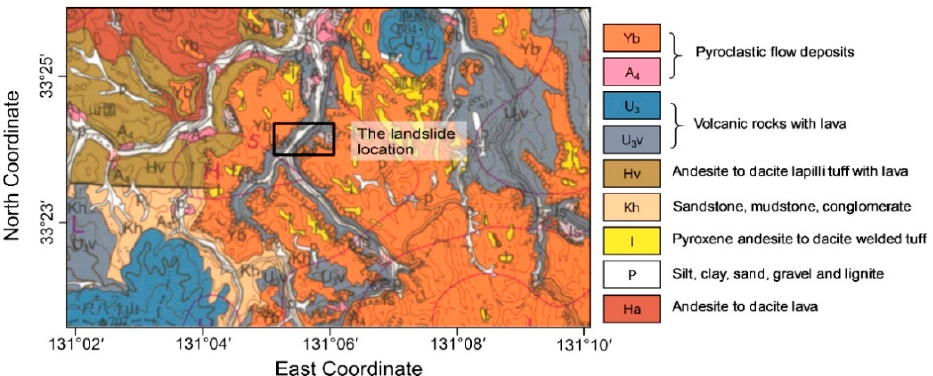
Figure 5. Geological setting of the Yabakei-Nakatsu area.